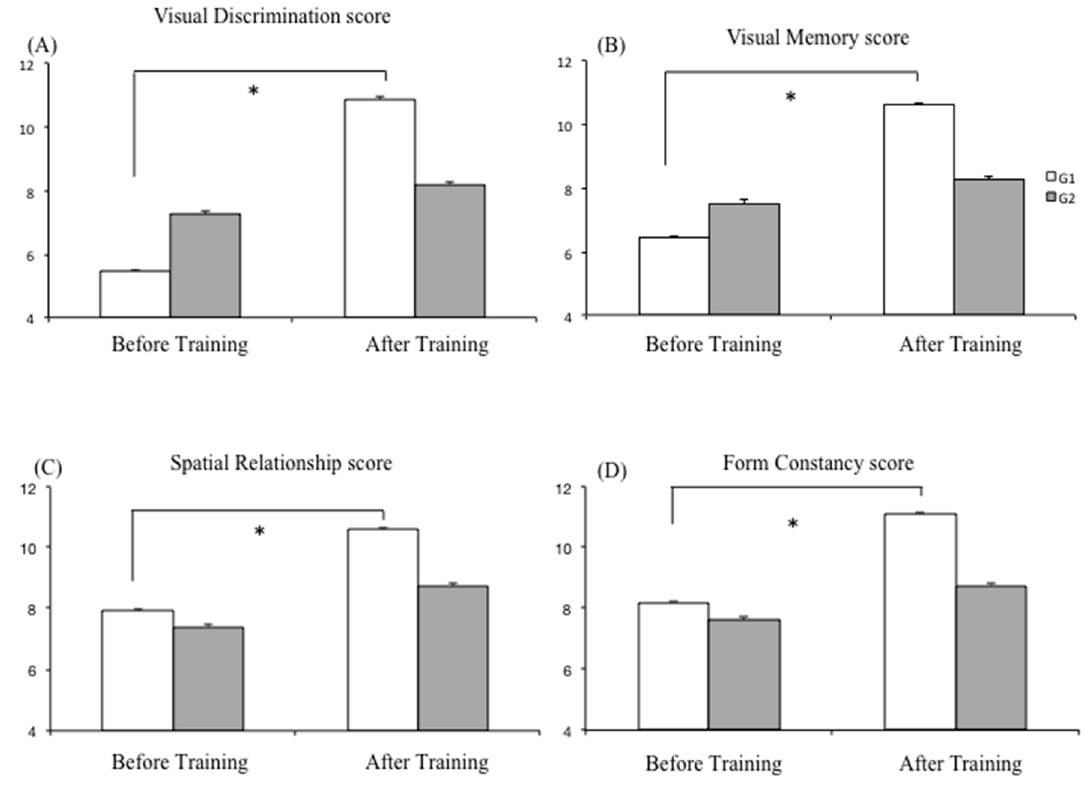
Figure 3. Means and standard deviations of scores measured in the different subtests of the TVPS: ( A ) Visual Discrimination, ( B ) Visual Memory, ( C ) Spatial Relationships, and ( D ) Form Constancy, for the two groups of children with dyslexia (G1 and G2) recorded Before and After Training. Asterisks indicate that the value is significantly different ( p ≤ 0.05).